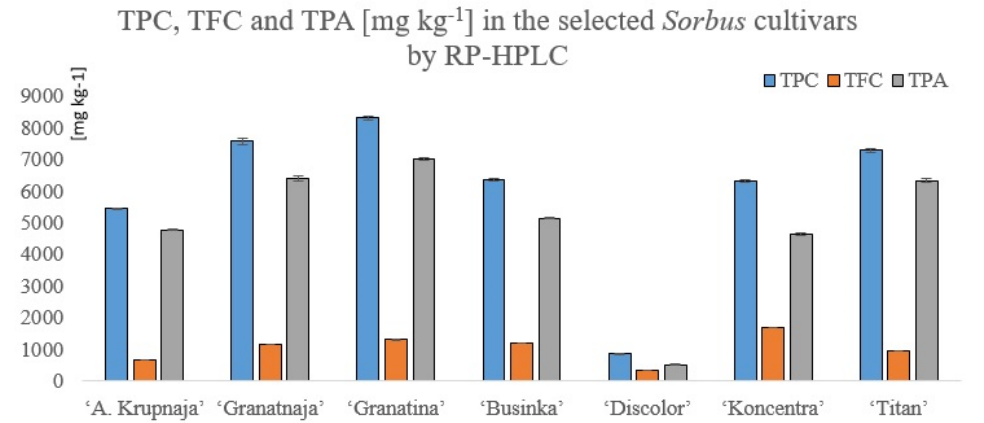
Figure 1. Total phenolic (TPC), flavonoid (TFC) and phenolic acid (TPA) contents in [mg kg − 1 ] in the selected Sorbus cultivars detected by RP–HPLC.